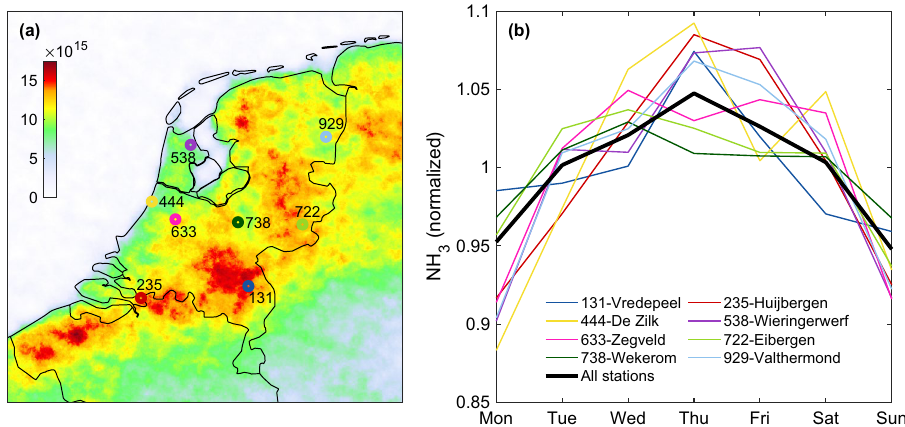
Figure 3. ( a ) Location of the National Air Quality Monitoring Network (LML) stations in the Netherlands superimposed on the IASI-NH 3 (molec cm Normalized NH 3 day of the week time-series measured at the height LML sites and presented individually (coloured lines) and all sites considered together (black